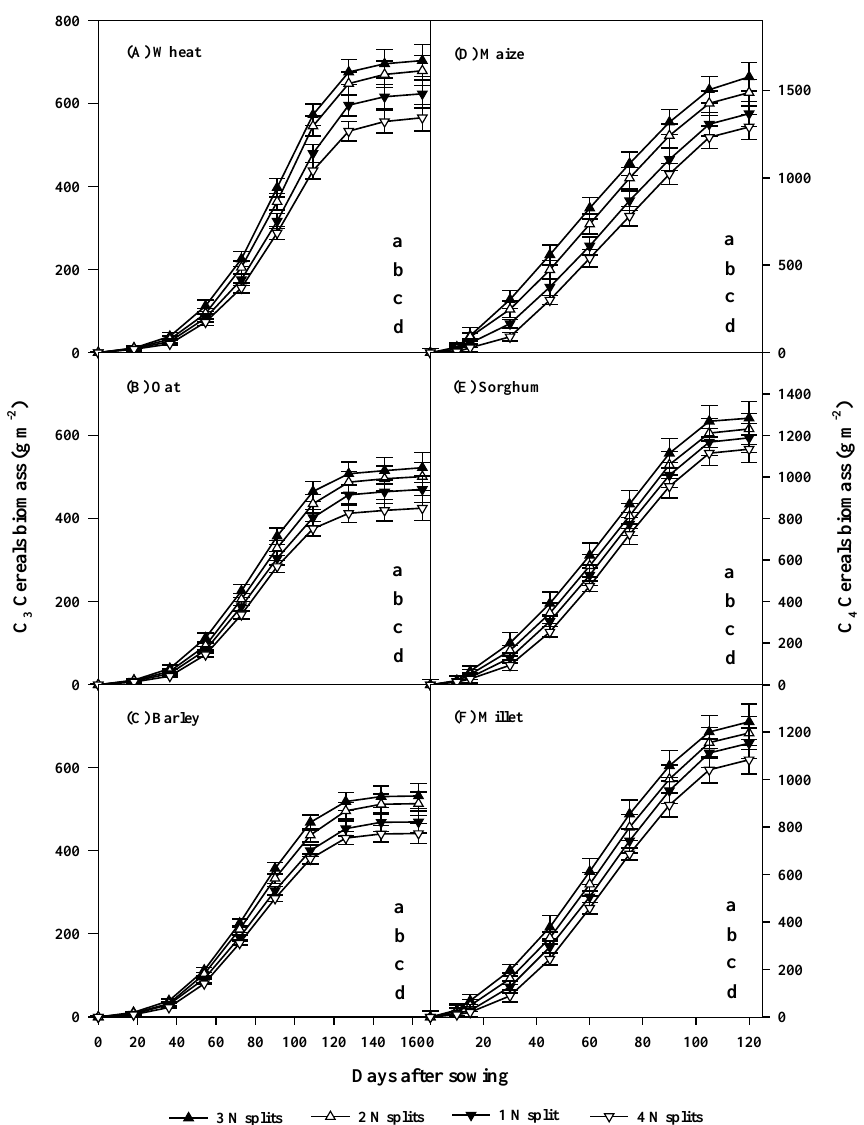
Figure 5. Total biomass production of winter C 3 ( A – C ) and summer C 4 ( D – F ) cereals under split N application regimes. Bars and letters represent standard error and significance, respectively.